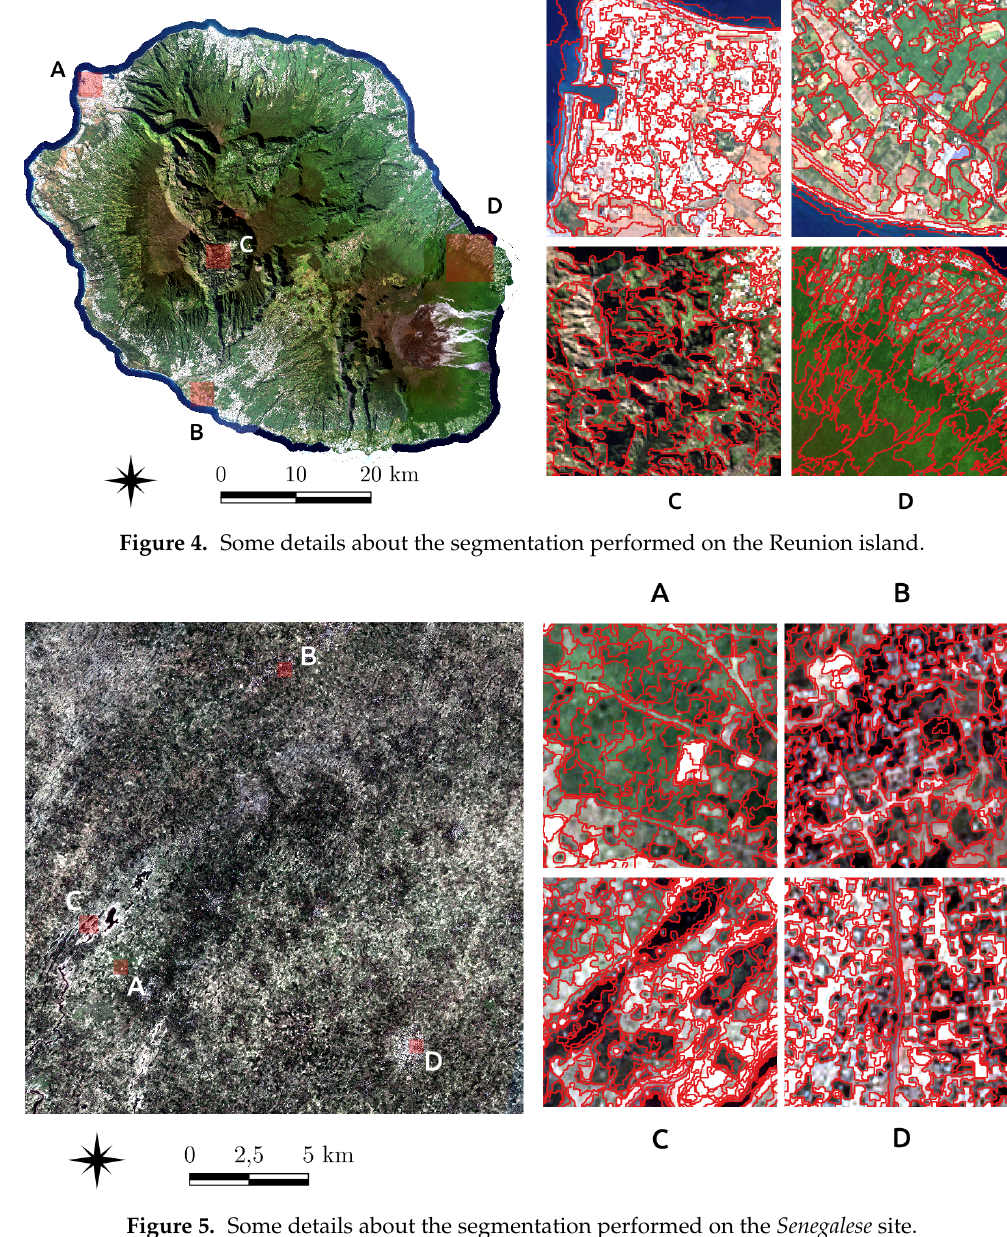
Figure 5. Some details about the segmentation performed on the Senegalese